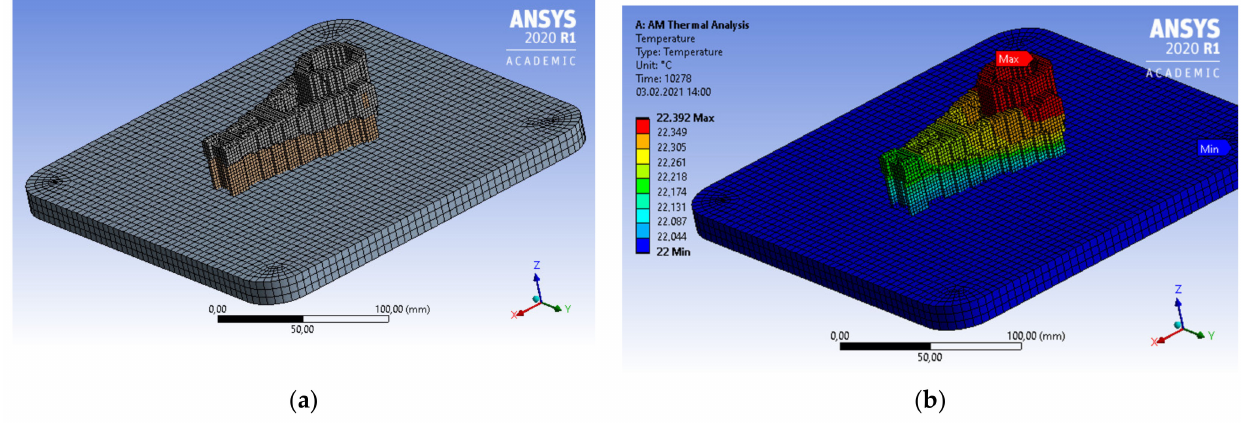
Figure 8. Additive manufacturing (AM) meshing for thermal analysis ( a ); thermal analysis results ( b